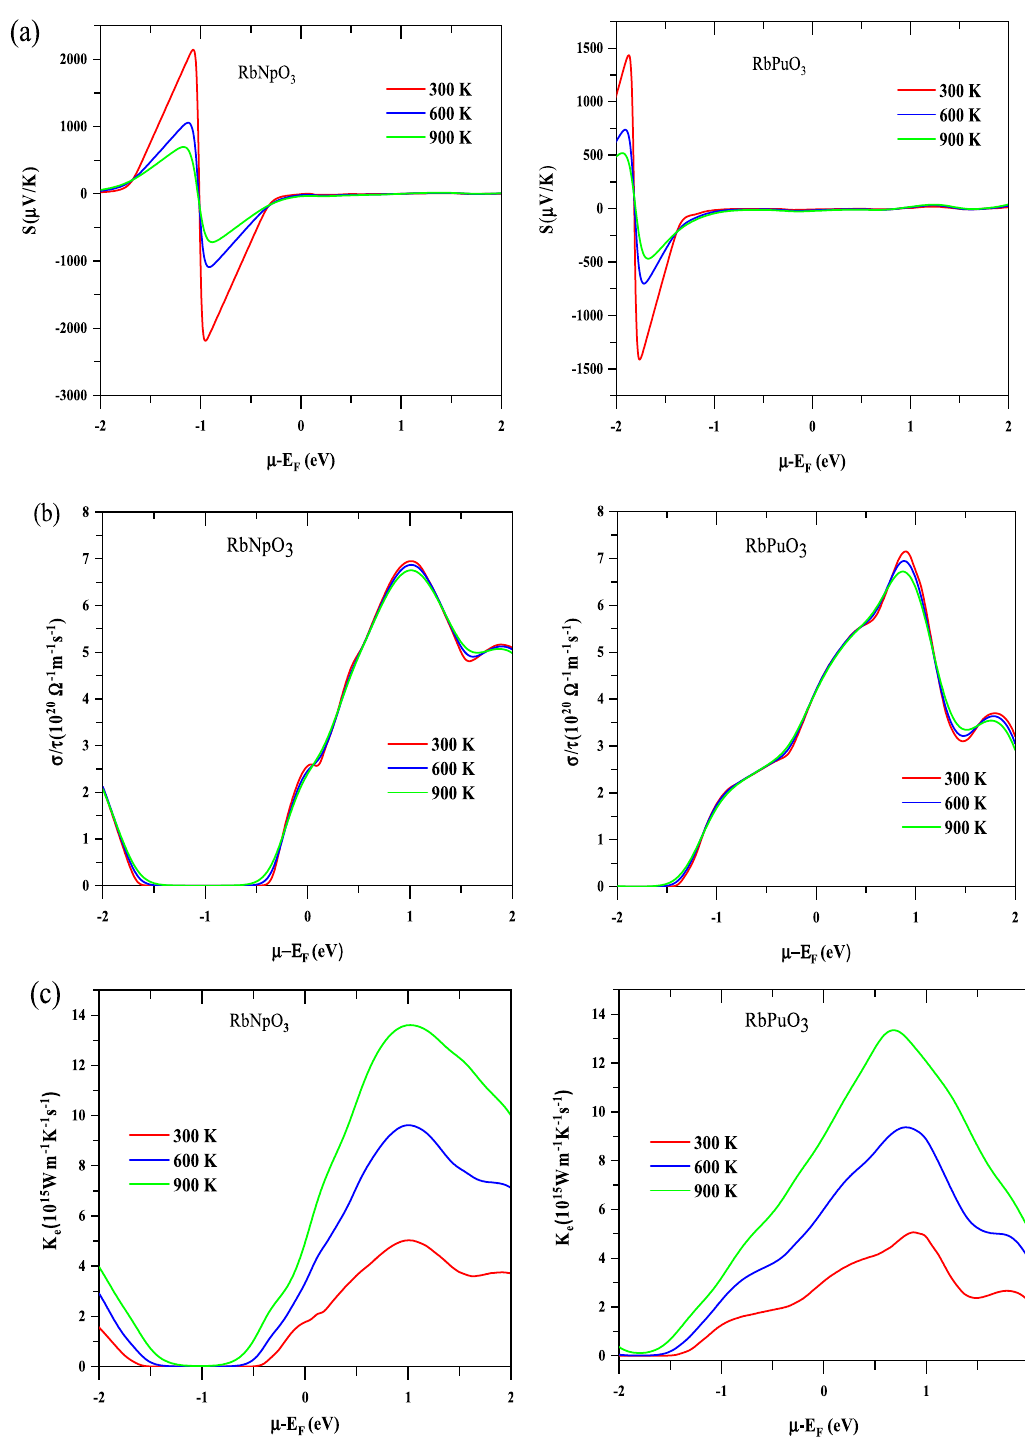
Figure 8. Thermoelectric plots of RbMO 3 perovskites against chemical potential at various temperatures, viz; ( a ) Seebeck coefficient (S), ( b ) electrical conductivity ( σ/τ ), ( c ) electronic thermal conductivity ( κ e ), ( d ) power factor (PF), and ( e ) figure of merit (Z e T). Temperature is denoted by several colours: red-300 K, blue-600 K, and green-900 K